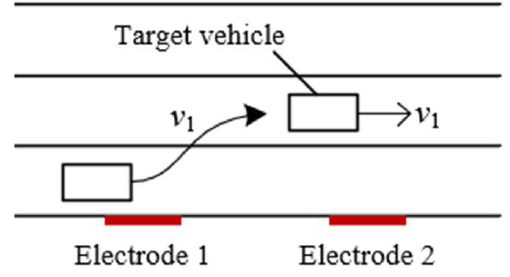
Figure 12. Diagram of lane changing.